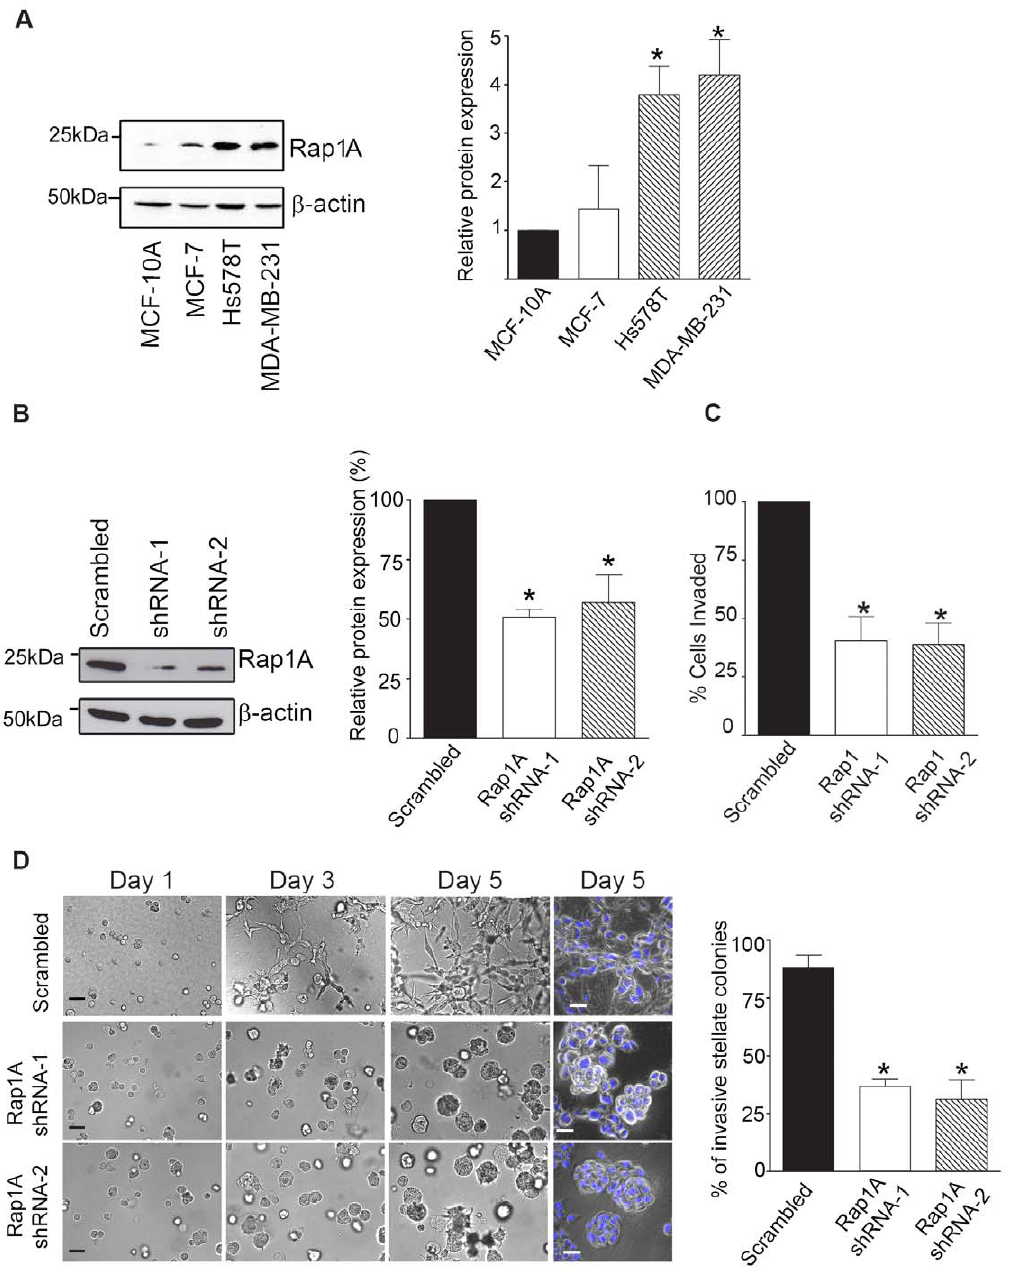
Figure 2. Rap1A is abundantly expressed in invasive human breast cancer cells and regulates invasiveness. (A) The aggressive breast cancer cell lines MDA-MB-231 and Hs578T express elevated levels of Rap1A protein relative to the non-invasive MCF-7 cells or the non-malignant MCF-10A mammary epithelial cells. Endogenous expression of Rap1A in each cell line was determined by Western blot analysis. A representative blot from five separate experiments is shown. In the graphs, bars represent relative expression to MCF-10A cells. Error bar, SEM *, p , 0.05. (B) Knockdown of Rap1A protein expression in MDA-MB-231 cells stably expressing two separate Rap1A shRNA constructs was verified by Western blot analysis. Densitometric analysis shows significantly lower levels of Rap1A expression in Rap1A shRNA expressing cells. *, p , 0.05. (C) Knock-down of endogenous Rap1A in serum-starved MDA-MB-231 cells inhibits LPA (10 m M) stimulated cell invasion as assessed using Transwell chamber (Matrigel) invasion assays. (D) MDA-MB-231 cells expressing Rap1A shRNA and suspendend in Matrigel for 5 days display reduced growth of invasive stellate structures relative to cells expressing scrambled control. Nuclei were stained using Hoechst 33258 and visualized by confocal microcopy (blue, last column of panel). Images are representative of five independent experiments, scale bar = 40 m m. Shape of the colonies was scored as either stellate or spheroidal and the number of stellate colonies is expressed as percentage of the total number of colonies. *, p , 0.05 compared to formation of stellate structures by MDA-MB-231 cells expressing scrambled shRNA.